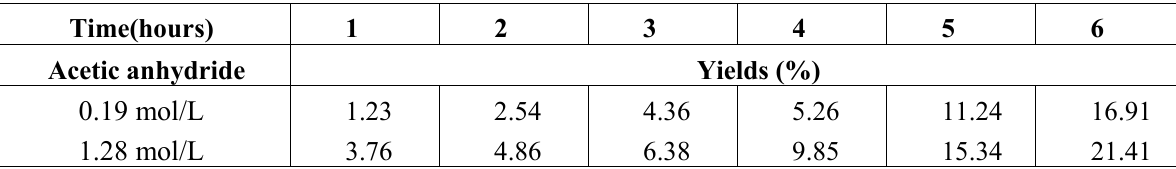
Polymer yields with time for 10.75 mol/L of THF, 8.43 mol/L of maleic anhydride, 2.5% of Maghnite-H+ 0.25M. Time(hours) 1 Acetic anhydride Yields